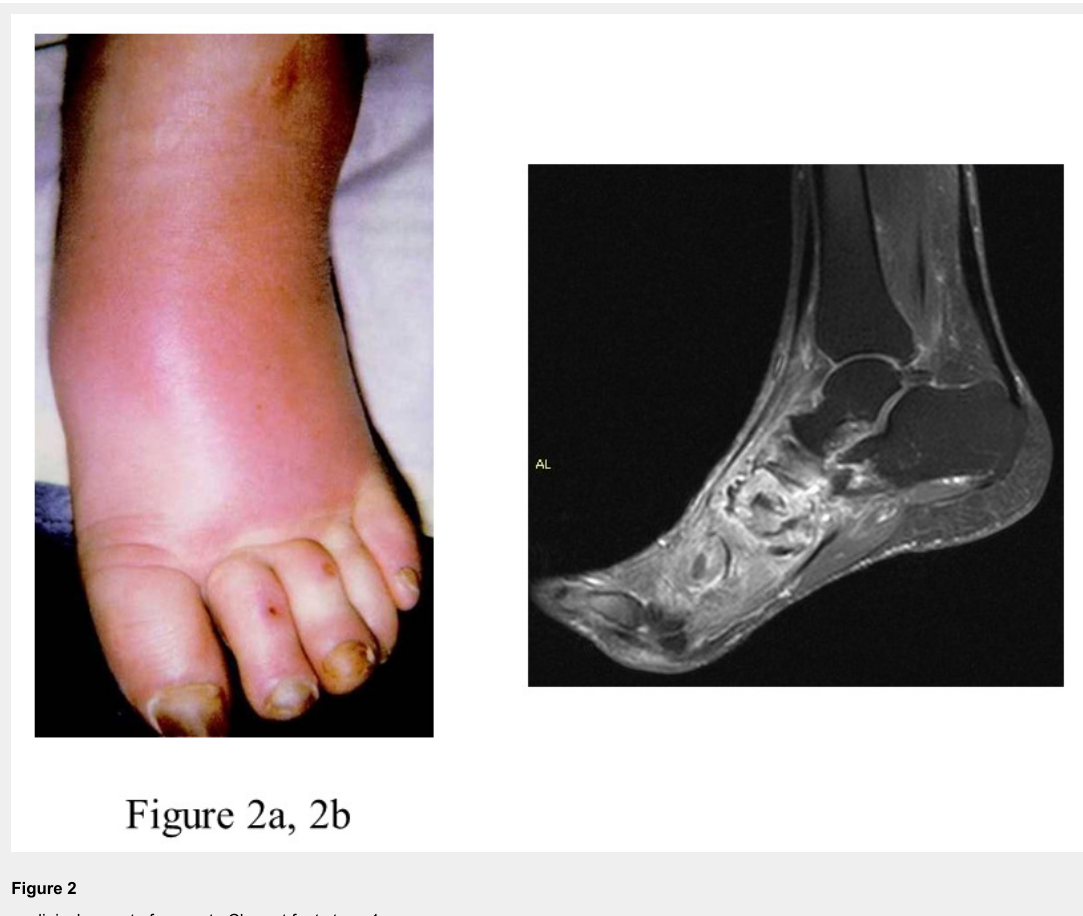
Figure 2 a: clinical aspect of an acute Charcot foot stage 1. b: MRI (T1w, fat suppressed, with contrast media) showing bone marrow oedema and impact fractures in the Lisfranc joints, a fluid collection with circular structure (equivalent to synovial fluid leakage and/or fracture hematoma) in the tarsal region, and adjacent soft tissue oedema (bright